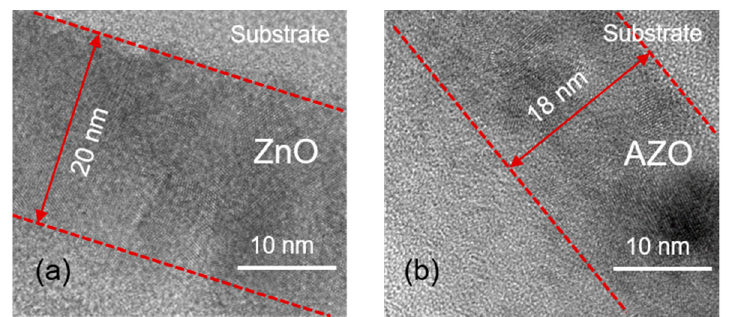
Figure 5. TEM images of a cross section of ( a ) ZnO film and ( b ) AZO film. Al cycle ratio of AZO film is 3%. ZnO and AZO films were deposited on silicon substrates.